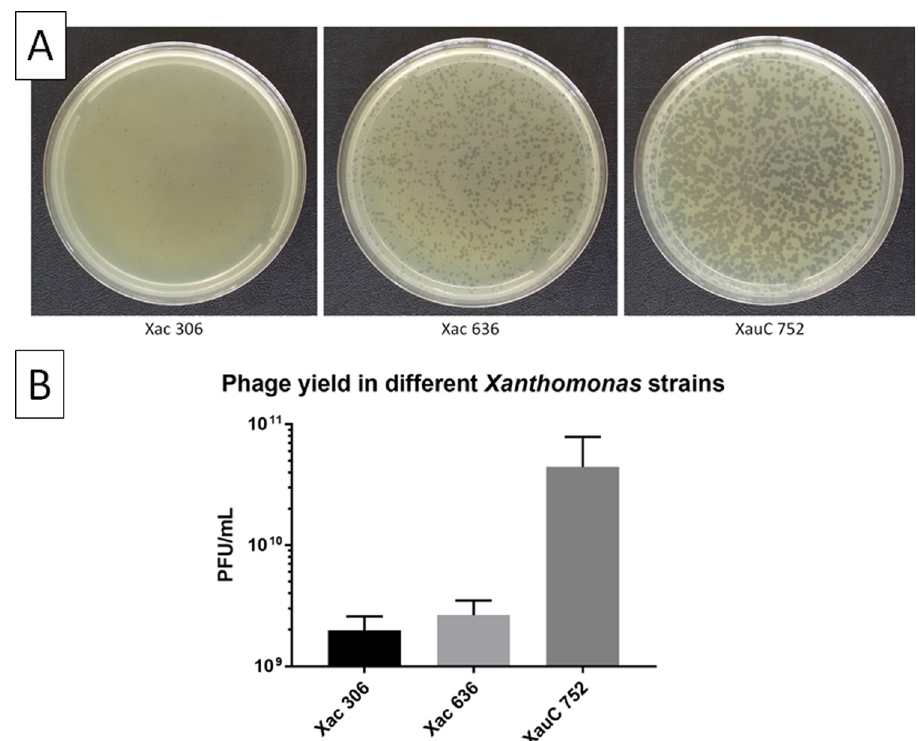
Fig 7. Plaque morphology and phage yield in different Xanthomonas strains. Plaques formed by vB_XciM_LucasX on semi-solid NB-agar plates are larger when strains Xac 636 and XauC 752 are used as hosts (A) . The plates were photographed after 48 h at 30˚C. When propagated in liquid medium, phage yield is slightly higher in Xac 636 and about one order of magnitude higher in XauC 752 relative to Xac 306 (B) . The graph was produced using the software GraphPad Prism and the bars indicate the standard deviation of three